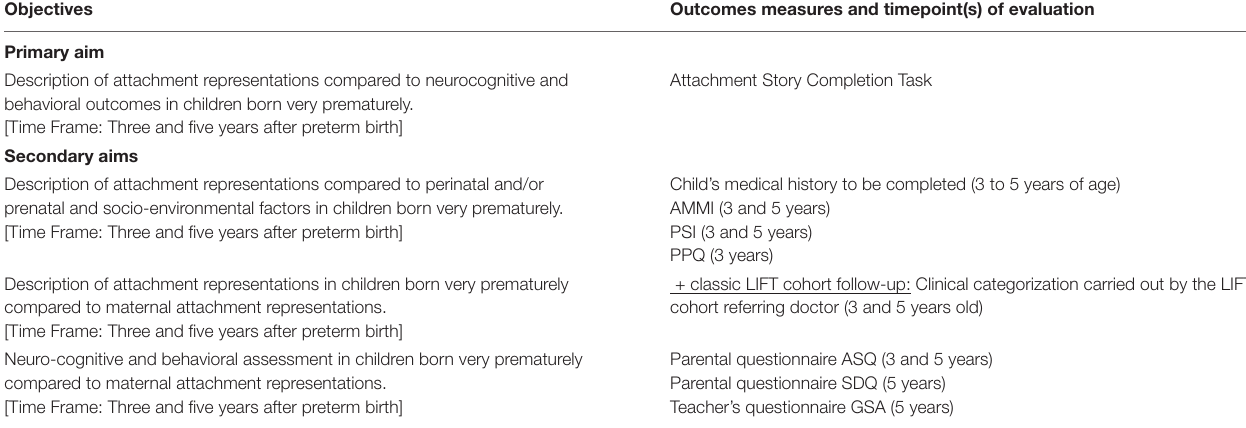
TABLE 3 | Outcome measures. Objectives Outcomes measures and timepoint(s) of evaluation Primary